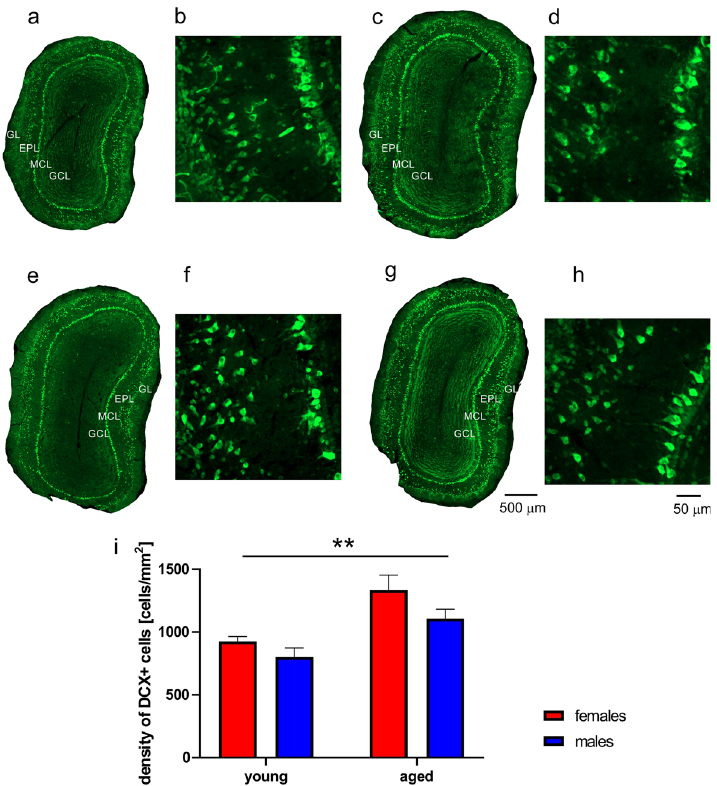
Figure 6. Localization of HuD in the olfactory bulb (OB) of opossums. ( a – h ) HuD immunostained neurons in the OB of young females ( a , b ), young males ( c , d ), aged females ( e , f ) and aged males ( g , h ). ( b , d , f , h ) Higher magnification images from ( a , c , e , g ) respectively. GL glomerular layer, EPL external plexiform layer, MCL mitral cell layer, GCL granule cell layer. The scale bar in ( h ) refers to ( b , d , f , h ) and the scale bar in ( g ) refers to ( a , c , e , g ). In ( i ) **indicates p = 0.002.